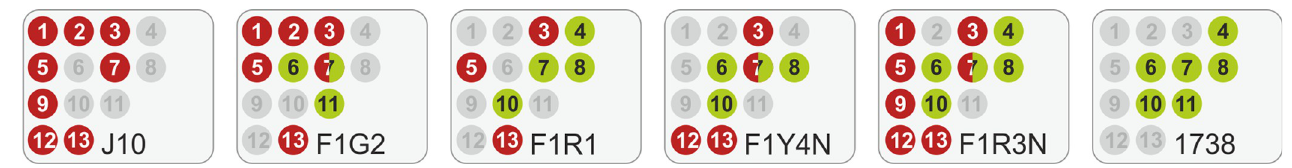
Fig 4. Metacyclic VSG expression sites in parents and hybrid progeny. Contigs containing mVSG promoters were clustered by neighbour-joining into 13 distinct loci, represented by coloured circles, where parental origin is indicated by colour (red = J10, green = 1738). The parents J10 and 1738 share only locus 7 in common (within 4% identity over the aligned region). Each hybrid has inherited loci from each parent as shown. For locus 7, both parental copies were present in F1G2, F1Y4N and F1R3N. F1R3N has all but two of the parental loci.